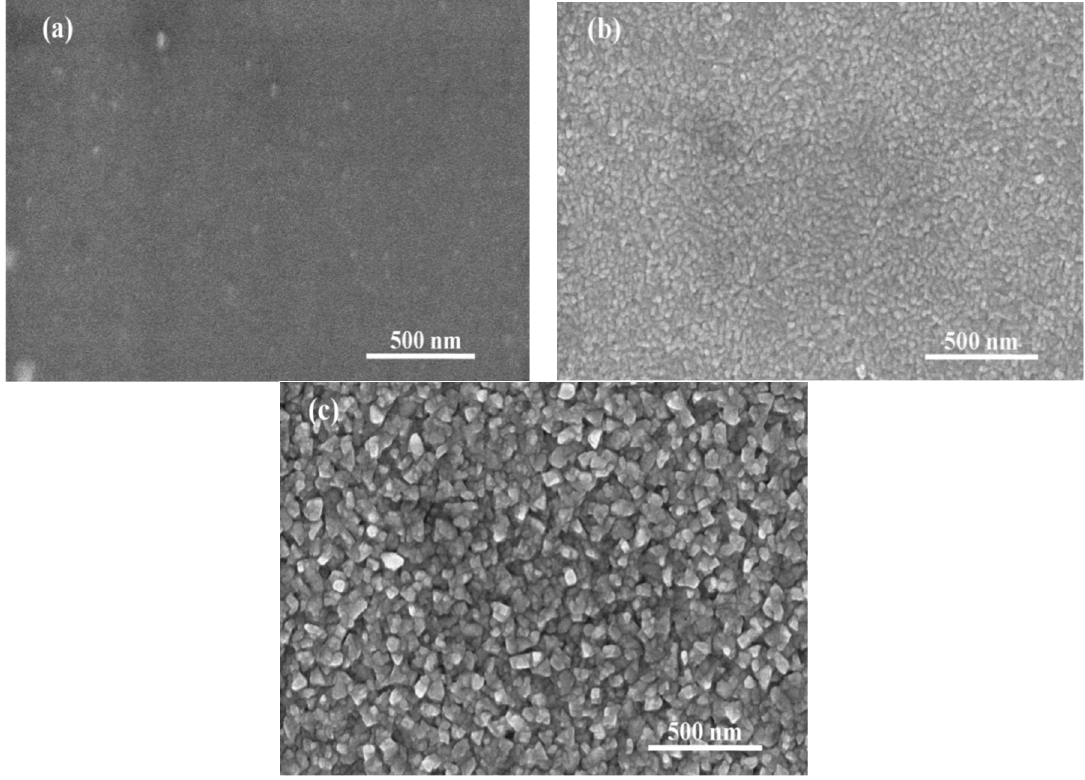
Figure 3. SEM images of AlSb:Zn thin films deposited at different substrate temperatures: ( a ) 300 °C; ( b ) 350 °C; ( c ) 400 °C.